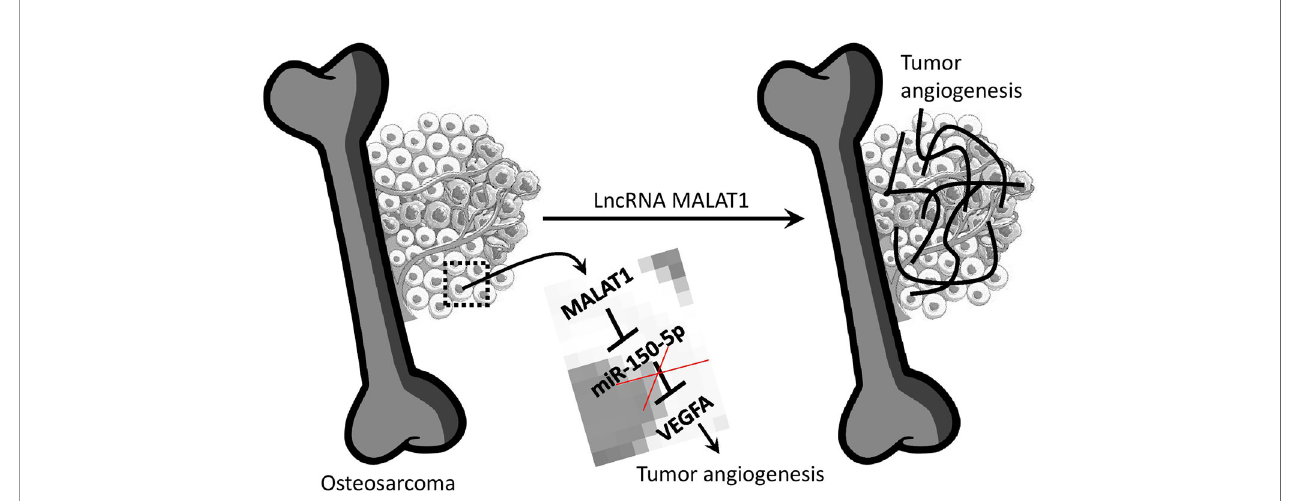
FIGURE 7 | Overview of lncRNA MALAT1 regulation of OS-induced angiogenesis. MALAT1 expression upregulates VEGFA by targeting miR-150-5p. This regulation saves VEGFA from miR-150-5p